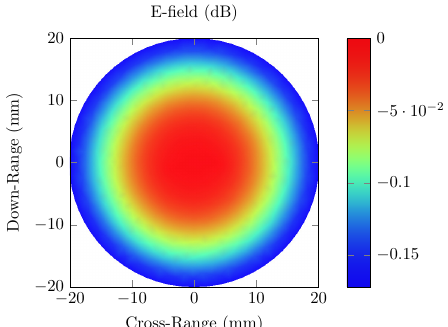
Figure 4. Total electric field intensity distribution inside the homogeneous phantom containing two absorbers, using a 434 MHz radio frequency (RF) source. The circular and elliptical absorbers, with conductivity σ = 10 S/m, are located 4 mm to the left and right of the center, and have a dielectric constant ε r = 25. The background has σ = 0.1 S/m, and ε r = 5.